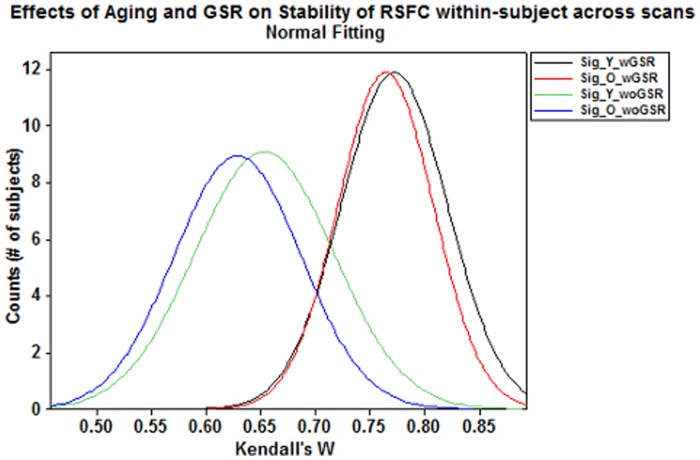
Effects of aging and GSR on stability of RSFC within-subject across scans.Frequency plots of Kendall’s W across scan sessions for significant correlations showed pronounced decreases in Sig. correlations with GSR. High stability of RSFC from scan to scan remains independent of aging effects.